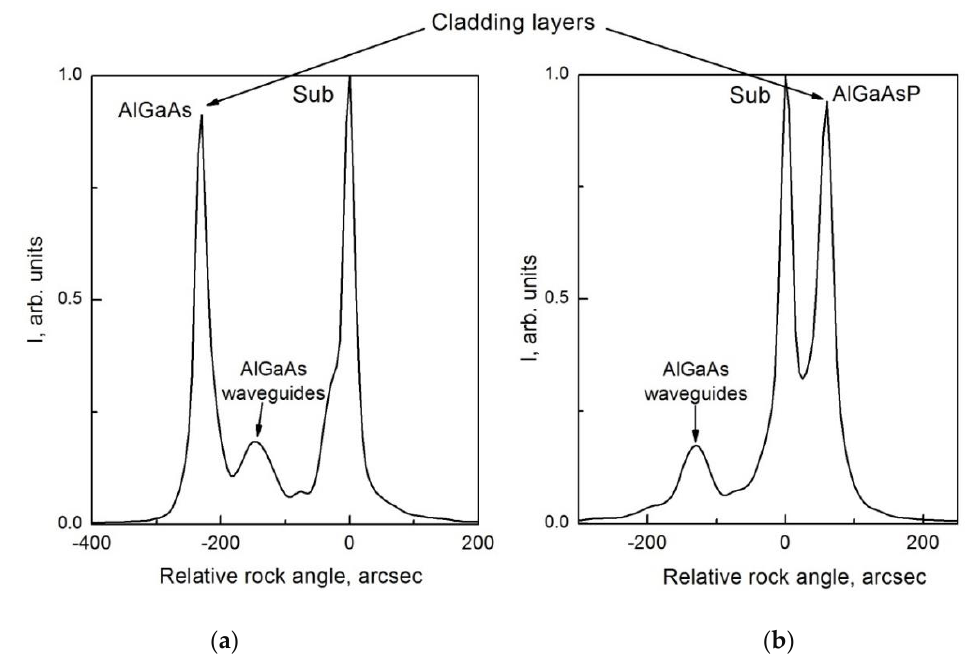
Figure 2. Rocking curves of AlGaAs/GaAs ( a ) and AlGaPAs/GaAs ( b ) laser heterostructures.